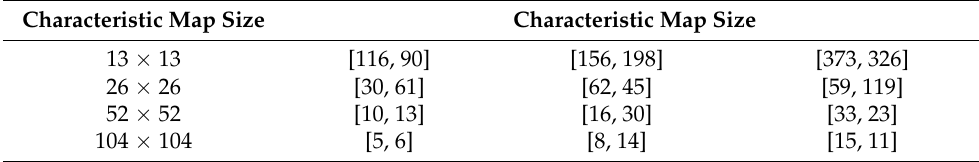
Table 2. The relationship between the size of the feature map and the size of the a priori box. Characteristic Map Size